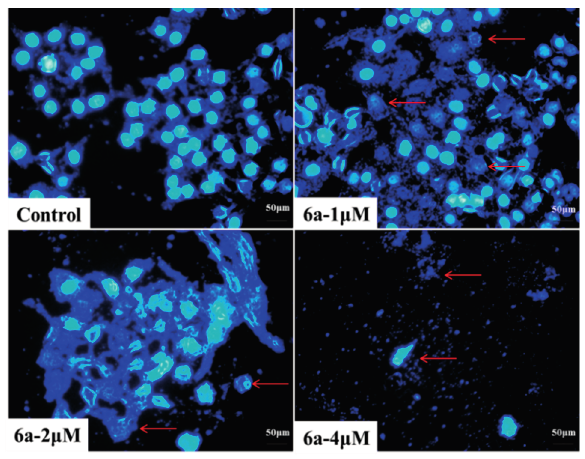
Figure 4. Nuclear fragmentation of HepG2 cells induced by compound 6a with